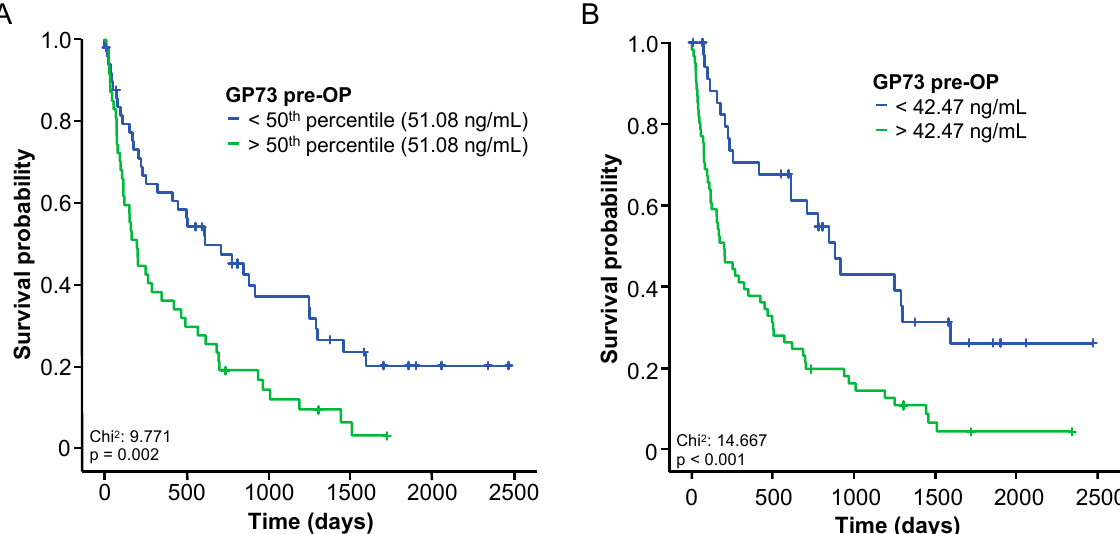
Figure 3. Elevated baseline levels of GP73 predict an impaired overall survival following BTC resection. ( A ) BTC patients with baseline GP73 serum levels above the 50th percentile (51.08 ng/mL) have a significantly impaired postoperative outcome. ( B ) At the optimal prognostic cut-off value (42.47 ng/mL), baseline GP73 levels identify a subgroup of BTC patients with a significantly impaired overall survival after tumor resection.